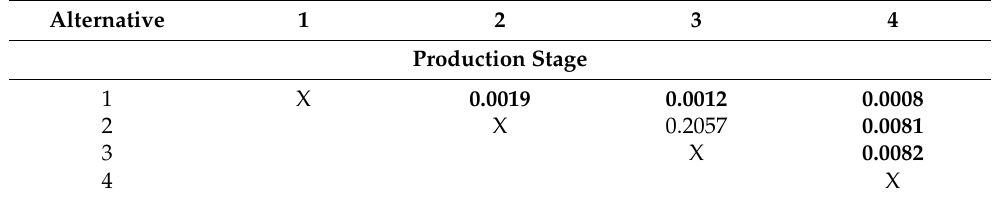
Figure 7. P&R stage: environmental damage of CB MinWin (1), CB MaxWin (2), AAB MinWin (3), and AAB MaxWin (4), evaluated with ReCiPe2016 endpoint single-score method using individualist/average (I/A), hierarchist/average (H/A), egalitarian/average (E/A), individualist/individualist (I/I), hierarchist/hierarchist (H/H), and egalitarian/egalitarian (E/E). Table 6. P&R stage: p -values of paired differences of CB MinWin (1), CB MaxWin (2), AAB MinWin (3), and AAB MaxWin (4).